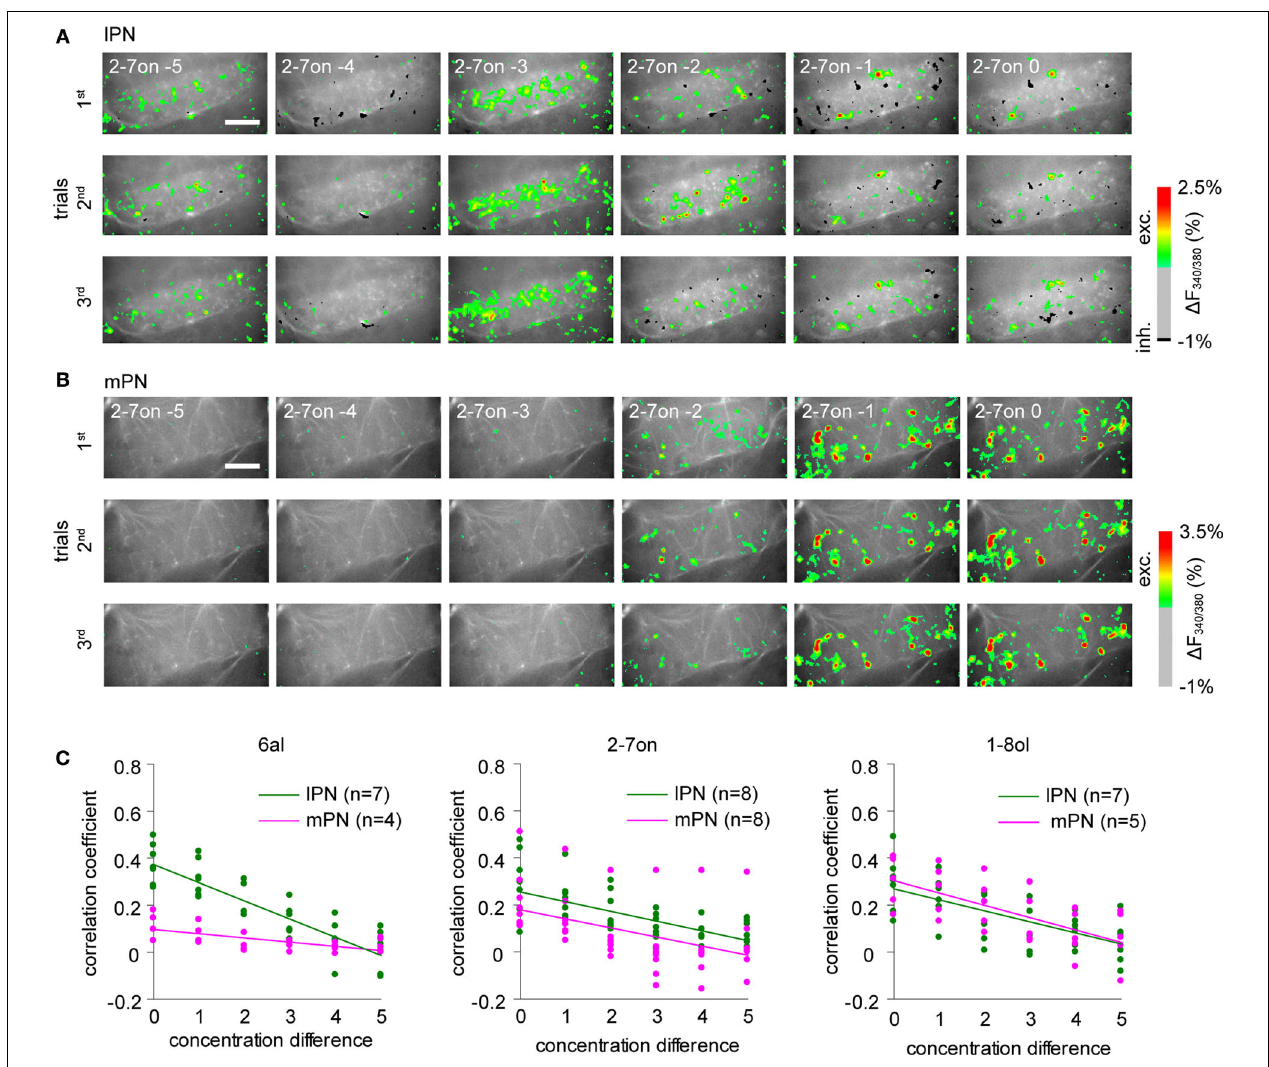
FIGURE 3 | Both lPN and mPN boutons encode odor concentration. Changes of spatial activity patterns with increasing odor concentrations (10 − 5 to 10 0 , in six steps) in lPN and mPN bouton populations. Representative example of lPN bouton responses (A) and mPN bouton responses (B) . Scale bars = 50 µm. (C) Response correlations between two concentrations plotted against their concentration differences. A value of zero in concentration difference indicates representation similarity in repetitions. Linear regression analyses revealed that